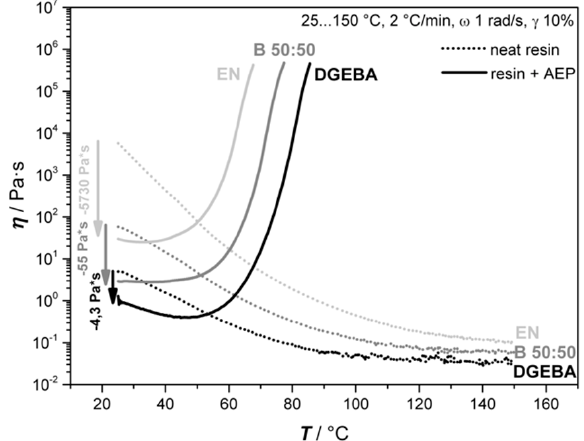
Figure 3. Rheological behaviors of DGEBA, EN, and their 50:50 blend (B 50:50) as neat resins and as a mixture with a stoichiometric amount of AEP.